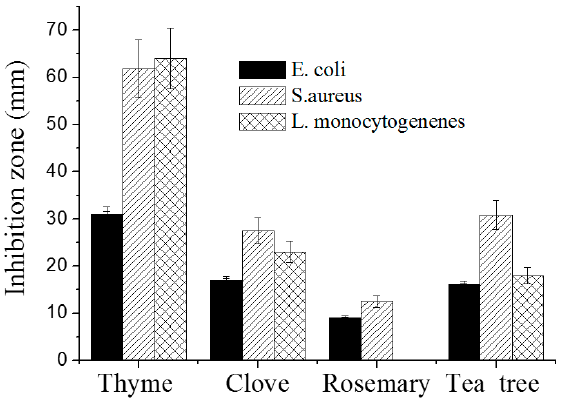
Figure 8. Antimicrobial activity of the four essential oils (EOs) (10 μ L on each disc) against S. aureus , E. coli, and L. monocytogenes using the agar disc diffusion method on an Mueller–Hinten (MH) Plate.